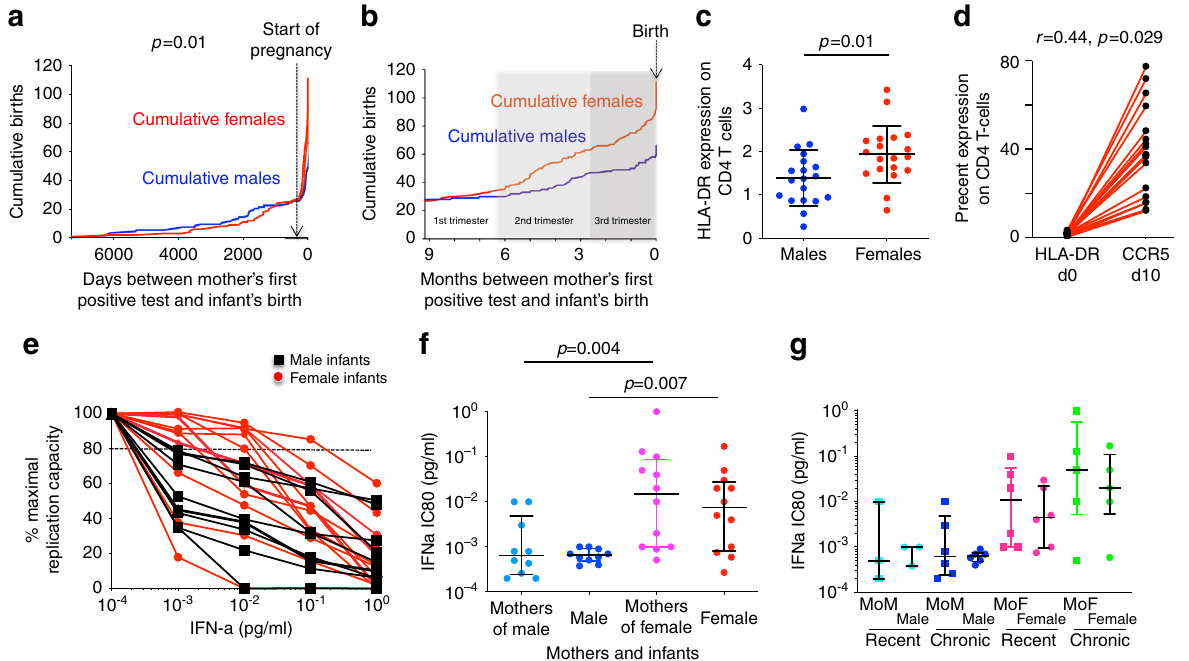
Fig. 2 Impact of timing of maternal infection in relation to sex differences in intrauterine transmission and in interferon-sensitivity of in utero transmitted viruses. a Cumulative number of male and female in utero transmissions by time (days) between mother ’ s fi rst HIV-positive test and the birth of the infant. Start of pregnancy shown as 280 days prior to delivery for simplicity (some infants were born prematurely). P value denotes sex difference in infants born to mothers whose fi rst HIV test was prior to pregnancy (de fi ned as ‘ chronically infected ’ ) versus those whose mothers ’ fi rst HIV test was during the pregnancy (de fi ned as ‘ recently infected ’ ) (Fisher ’ s Exact test, 2-sided). b Cumulative number of male and female in utero transmissions by time (months) between mother ’ s fi rst HIV-positive test and the birth of the infant in the mothers who fi rst tested positive during the pregnancy. As in ( a ), start of pregnancy shown as 280 days prior to delivery. c HLA-DR expression in cord blood CD4 + T-cells in 19 sets of HIV-uninfected sex-discordant twins. Medians and interquartile ranges are shown; the statistical test used was the unpaired t test (2-sided). d Correlation between CCR5 expression on CD4 T cells on day 10 and HLA-DR expression on CD4 T cells on day 0 in females. The correlation between GFP on day 10 with baseline HLA-DR expression was r = 0.35, p = 0.07 in females. In males, correlations between HLA-DR expression on day 0 and CCR5 expression on day 10 and GFP expression on